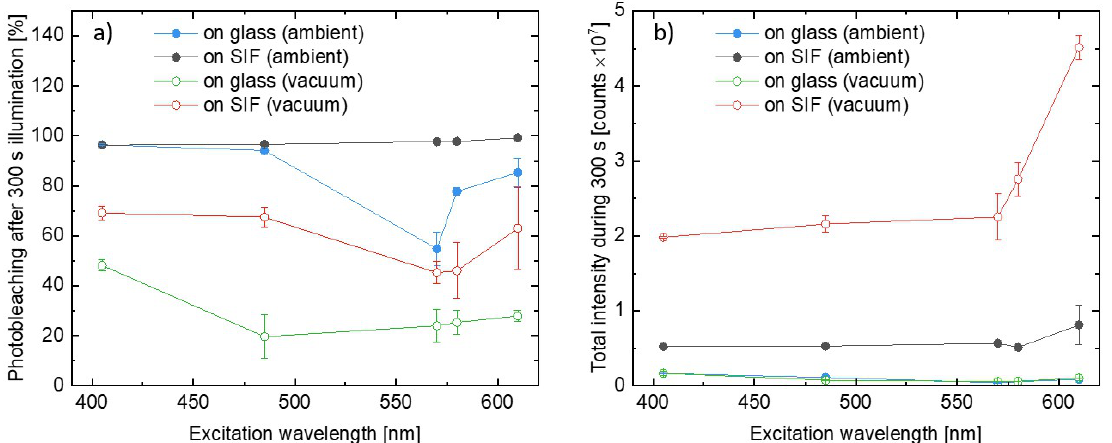
Figure 5. ( a ) Comparison of the relative photobleaching after 300 s of illumination in all considered conditions. ( b ) Comparison of the total light intensity emitted by the PSI–LHCI during the 300 s long illumination with laser light.